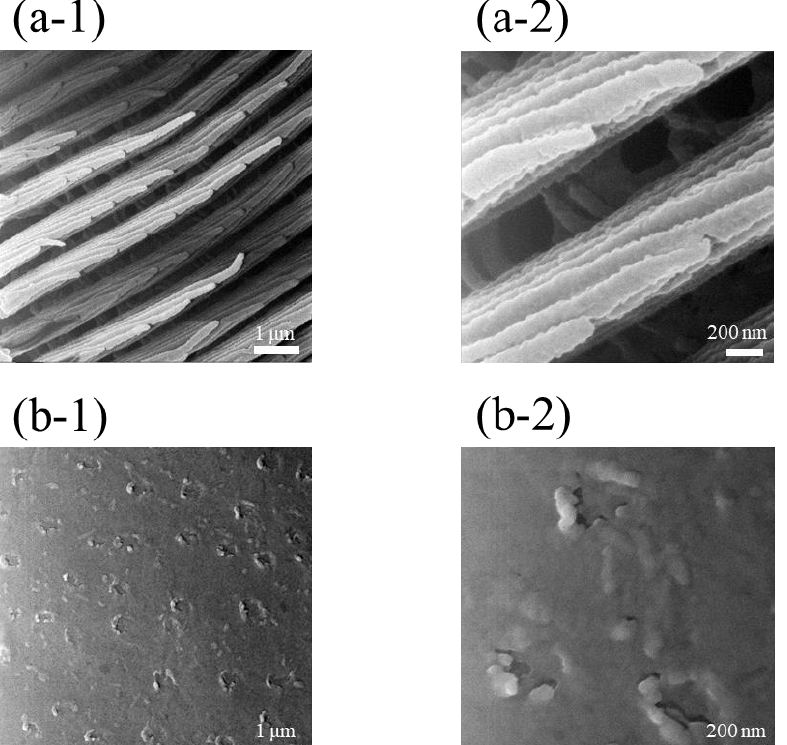
Figure A10. HIM images of ( a-1 , a-2 ) intact ridges and ( b-1 , b-2 ) stump-like structures of chestnut scale of S. charonda after removal of the upper layer.